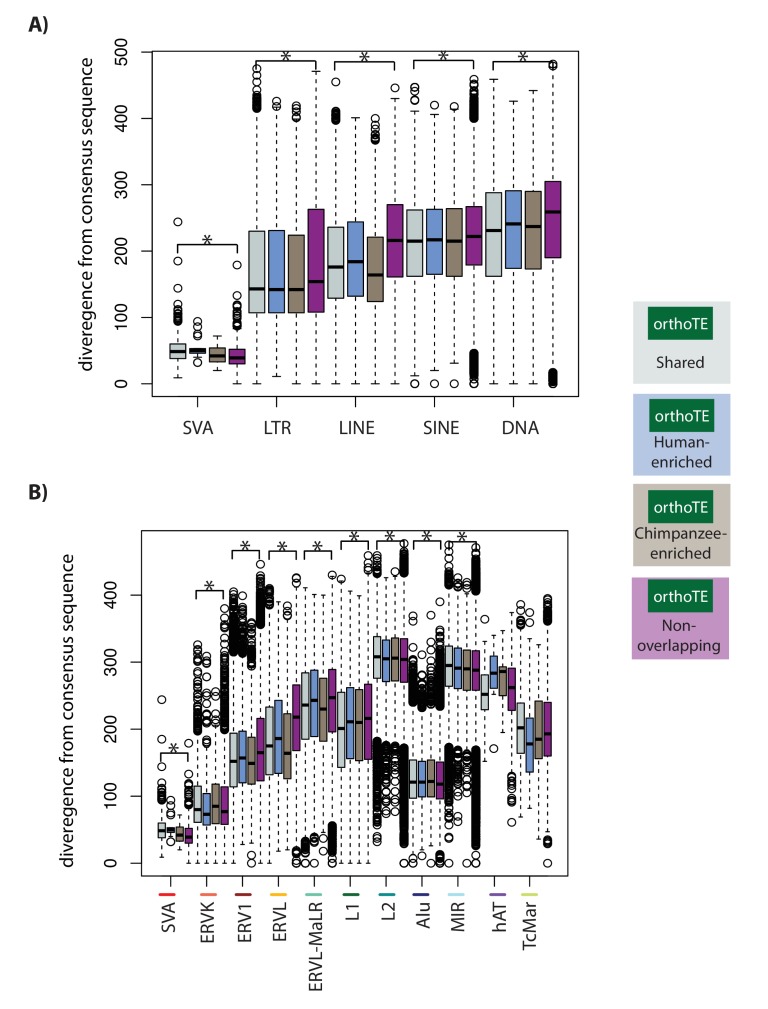
TEs, within a class, that are similarly enriched for H3K9me3 in both species tend to be less diverged from the consensus TE sequence than TEs that do not overlap H3K9me3 .(A) The divergence from the consensus sequence of TEs in each of the TE classes. (B) The divergence from the consensus sequence of TEs in 11 major TE families. Families are ordered by the proportion of TE instances that overlap H3K9me3 regions (highest-to-lowest from left-to-right). Asterisk denotes a significant difference between the Shared and Non-overlapping categories (Wilcoxon-rank sum test; *p<0.001).